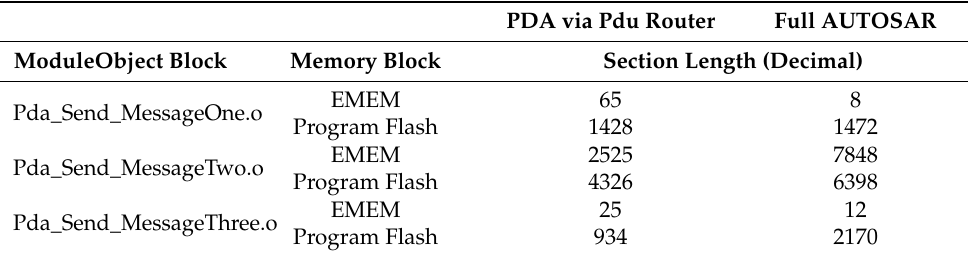
Table 2. PDA via Pdu Router vs. Full AUTOSAR Object Memory Usage.